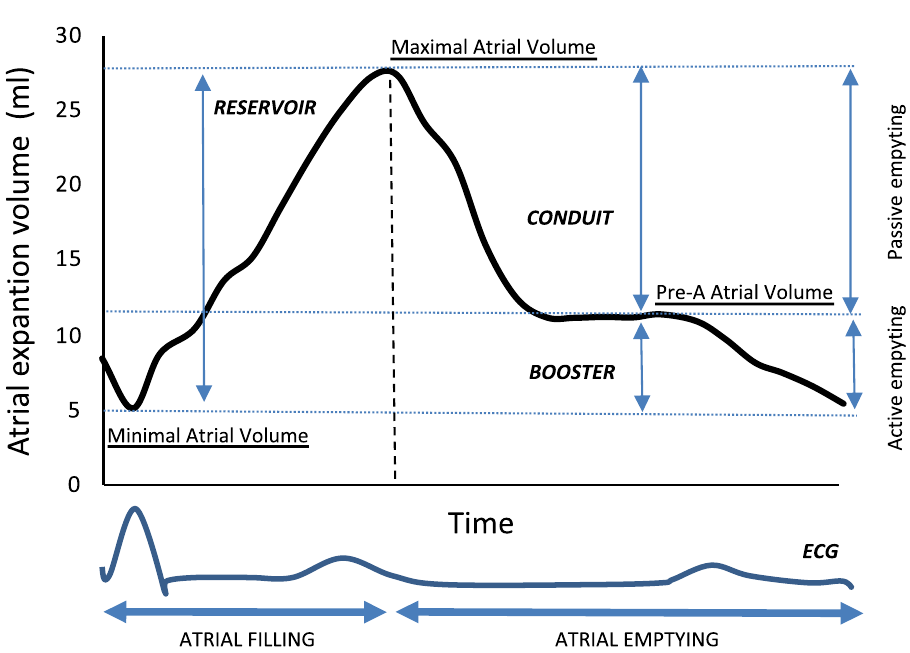
Figure 4. Schematic RA time-volume curve. RA time-volume curve with the assessment of parameters of atrial function. Reservoir, conduit, and booster volumes are calculated from atrial volumes at special time points. Reservoir function = Vmax-Vmin; Conduit function = Vmax-Vpre-A; Booster function = Vpre-A-Vmin; RV Vmax, maximum RV volume; RV Vmin, minimum RV volume; Pre-A: preatrial